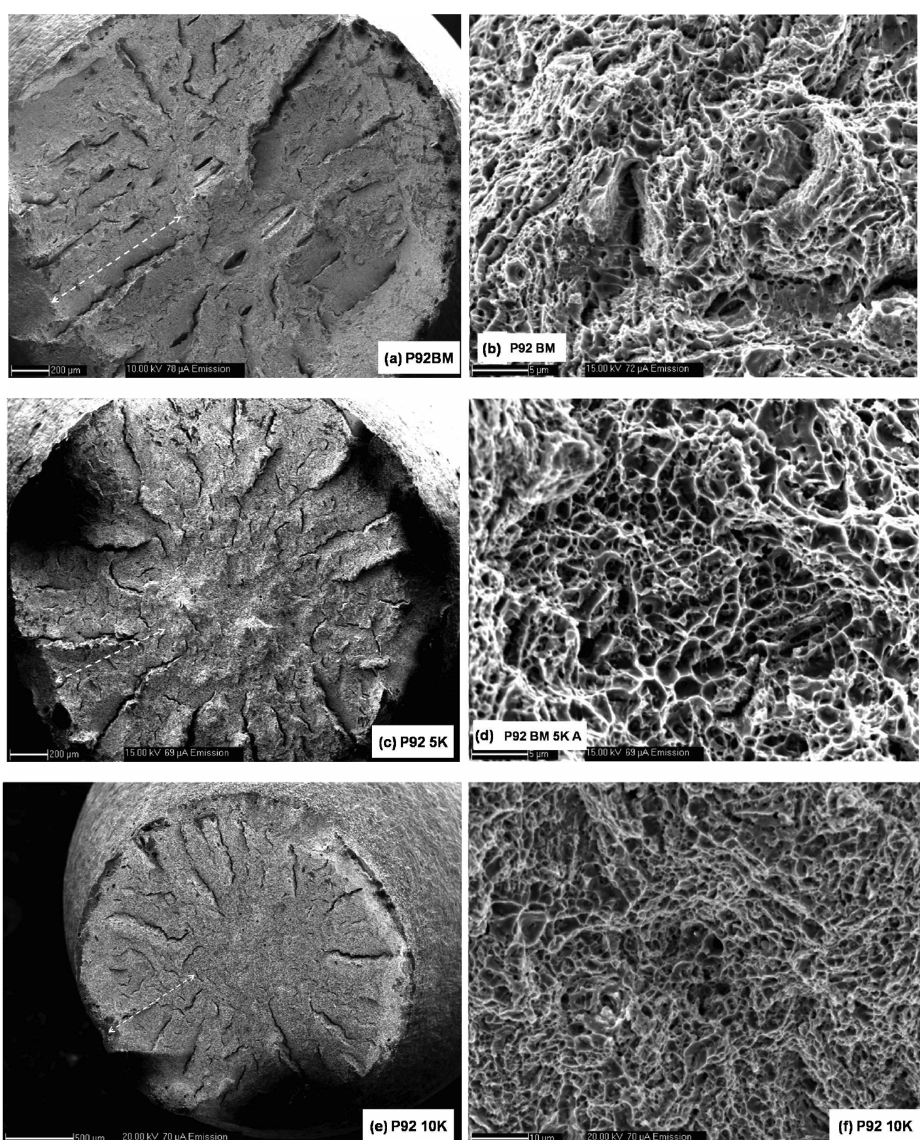
Figure 10: Fracture surface of the tensile tested P92 steel at 300 K in ((a) and (b)) normalized and tempered, and thermal aged ((c) and (d)) for 5000 h, and ((e) and (f)) for 10,000 h steels. Arrow mark indicates the chisel tip feature in the fracture surface which determines the extent of